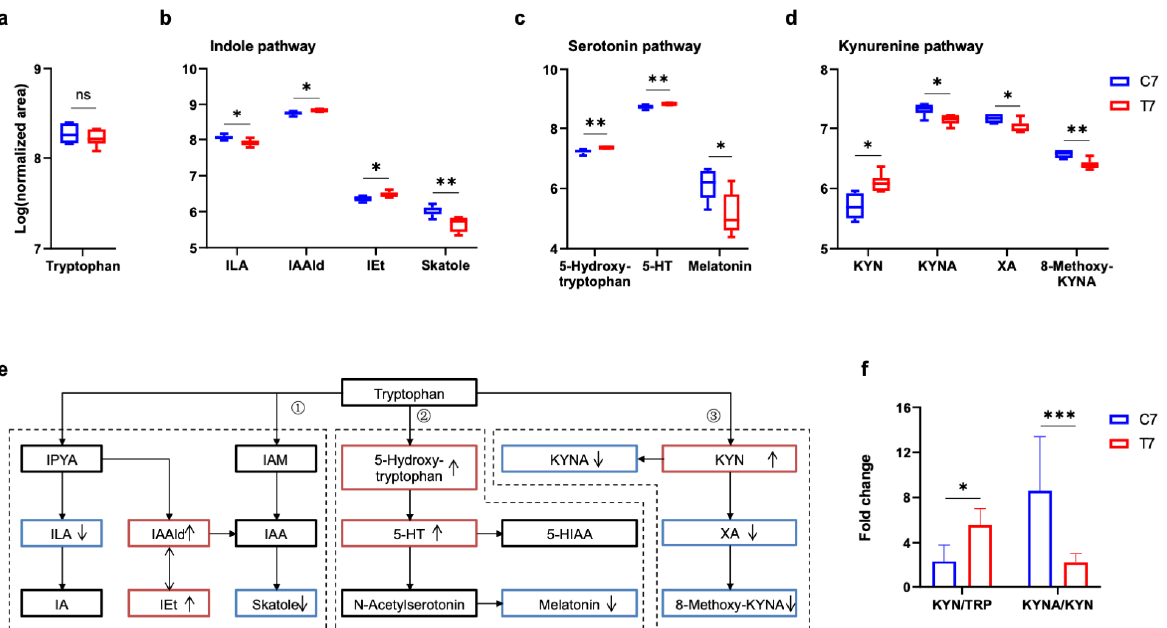
Figure 6. Alterations of the serum tryptophan metabolic pathway at 7 days post-TBI. Comparison of serum tryptophan ( a ) and major tryptophan metabolites in the indole pathway ( b ), serotonin pathway ( c ), and kynurenine pathway ( d ) at 7 days post-TBI. ( e ) Major tryptophan metabolism pathways are involved: (1) Indole pathway: Tryptophan can be directly metabolized by the gut microbiota into indole derivatives; (2) Serotonin pathway: Peripheral production of the neurotrans- mitter serotonin by enterochromaffin cells is influenced by the gut microbiota, and the brain can also synthesize serotonin; (3) Kynurenine pathway: kynurenine-producing pathway plays a critical role in immune response and neurobiological functions, which is also affected by gut microbiota. ( f ) The ratios of KYN/TRP and KYNA/KYN at 7 days post-TBI. ↑ , increased; ↓ , decreased in 7 days post-TBI mice. The tryptophan and its metabolite listed in the pathways were marked with black (unchanged), red (increased), and blue (decreased) solid boxes. Data are shown as median with range. * p < 0.05, ** p < 0.01, *** p < 0.001 using unpaired Student’s t test. TBI, traumatic brain injury; TRP, tryptophan; IPYA, indole-3-pyruvic acid; ILA, indole-3-lactic acid; IA, indole acrylic acid; IAAld, indole-3-acetaldehyde; IEt, indole-3-ethanol (tryptophol); IAM, indole-3-acetamide; IAA, indole acetic acid; 5-HT, 5-hydroxytryptamine (serotonin); KYN, kynurenine; KYNA, kynurenic acid; XA, xanthurenic acid; ns, no